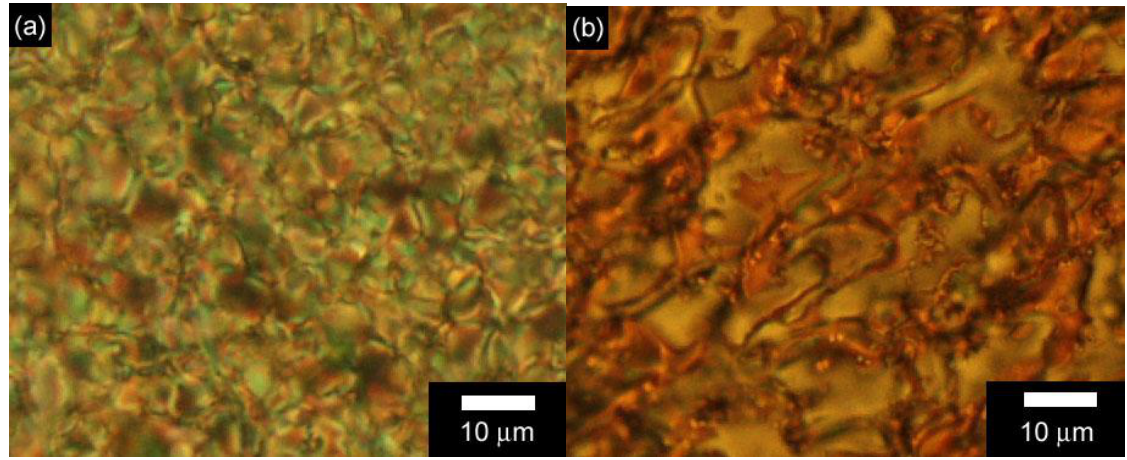
Figure 9. POM images of P1T at 130 °C (a) and P2T at 120 °C (b)